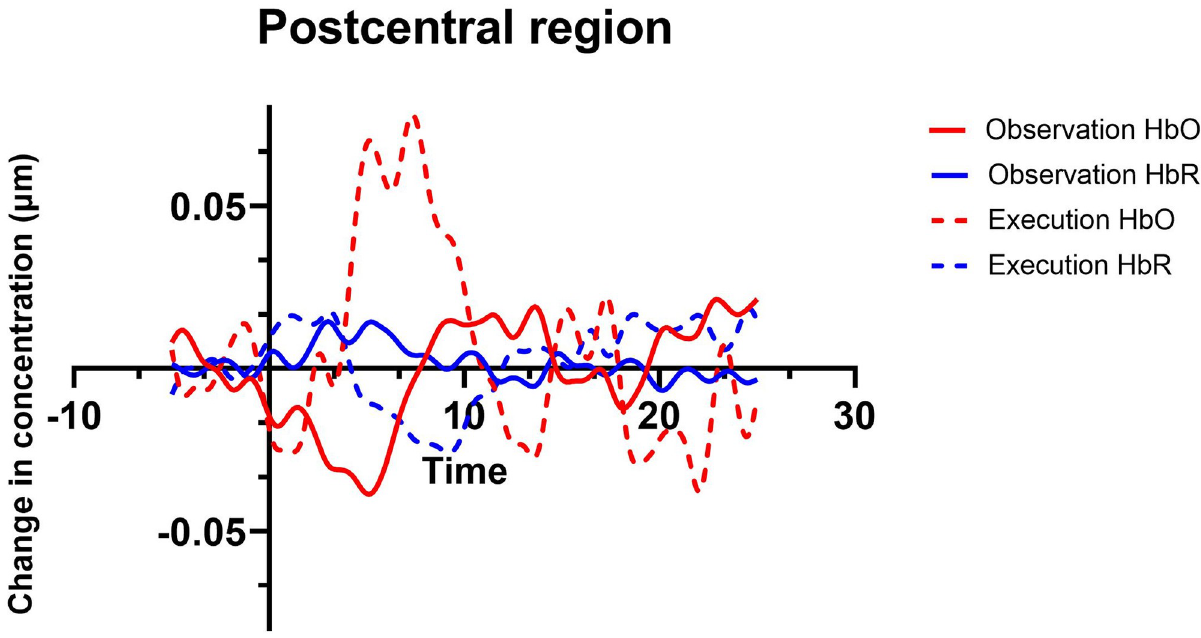
Fig 7. Hemodynamic response function for postcentral region during execution and observation